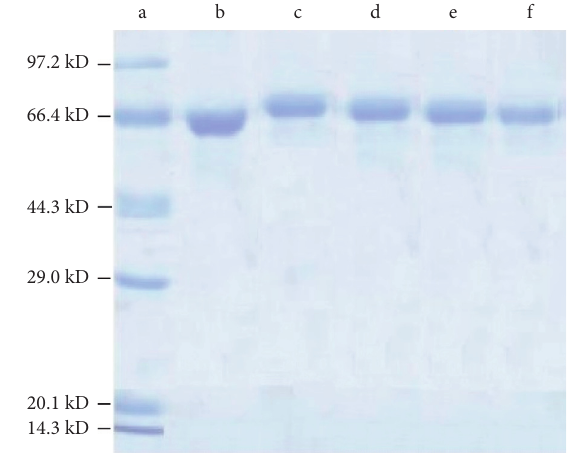
Figure 8: SDS-PAGE image of ZEN-BSA synthesized via the four methods. (a) Maker; (b) BSA; (c) ZEN-BSA (OAE); (d) ZEN-BSA (CMA); (e) ZEN-BSA (FA); (f) ZEN-BSA (BDE).